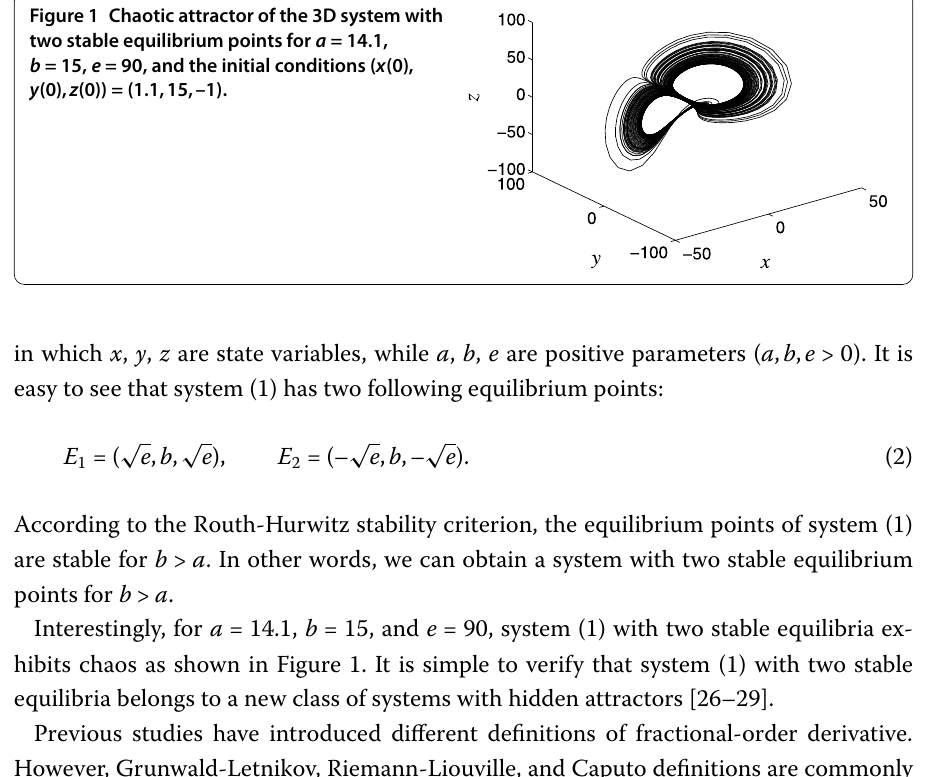
Figure 1 Chaotic attractor of the 3D system with two stable equilibrium points for a = 14.1, b = 15, e = 90, and the initial conditions ( x (0), y (0), z (0)) =